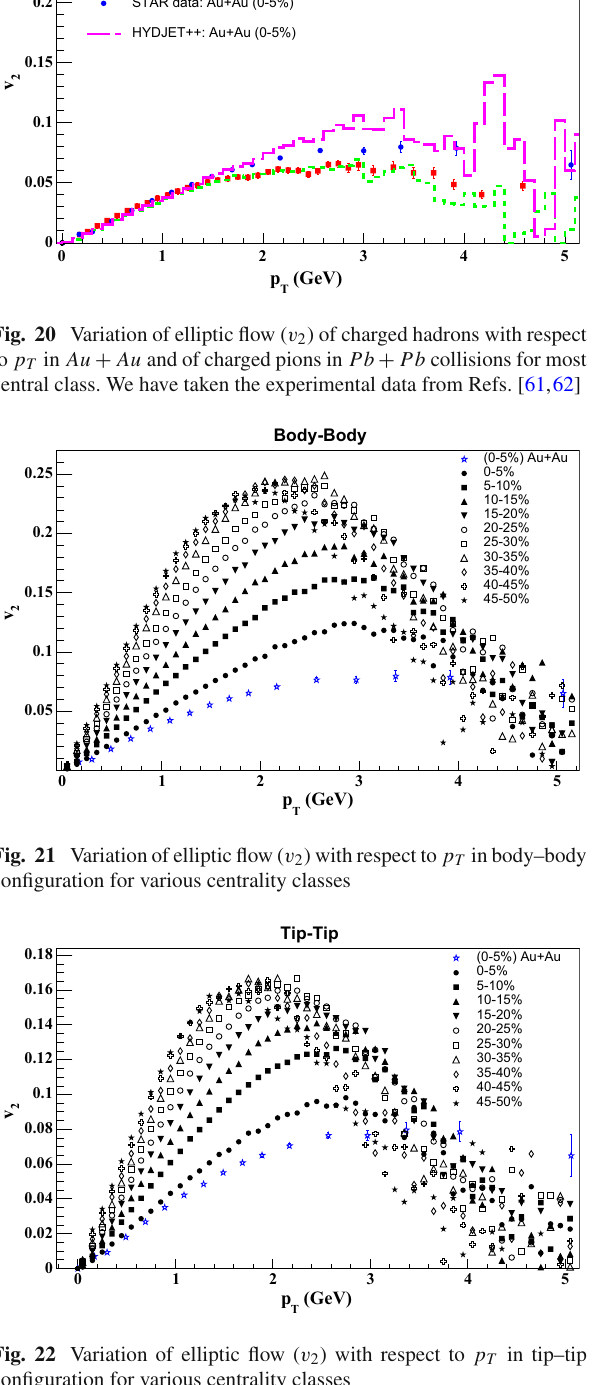
but in central collisions, initial configuration mostly affect the jet-fragmentation part at higher p T (as shown in Fig.